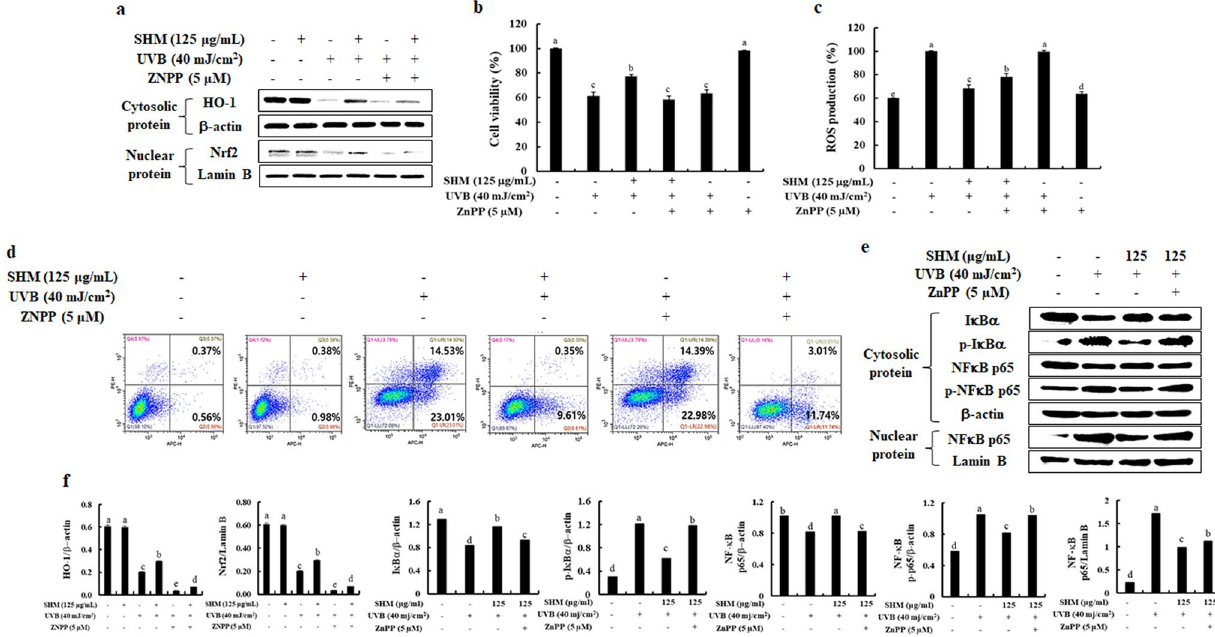
Figure 4. Influence of HO-1 inhibition on the protective effects of SHM in UVB-exposed human keratinocytes. Influence of HO-1 inhibition on ( a ) Nrf2/HO-1-related protein expression level, ( b ) cell viability, ( c ) intracellular ROS production, ( d ) population of early apoptotic and necrotic cells, ( e ) NF-κB-related protein expression levels in SHM-pretreated and UVB-exposed human keratinocytes, and ( f ) The density ratio of protein expression levels was analyzed via Image J software each in comparison to β-actin or Lamin B. Values are expressed as means ± SE of triplicate determinants (n = 3). a–e Bars with different letters for each molecule represent significant differences (P <